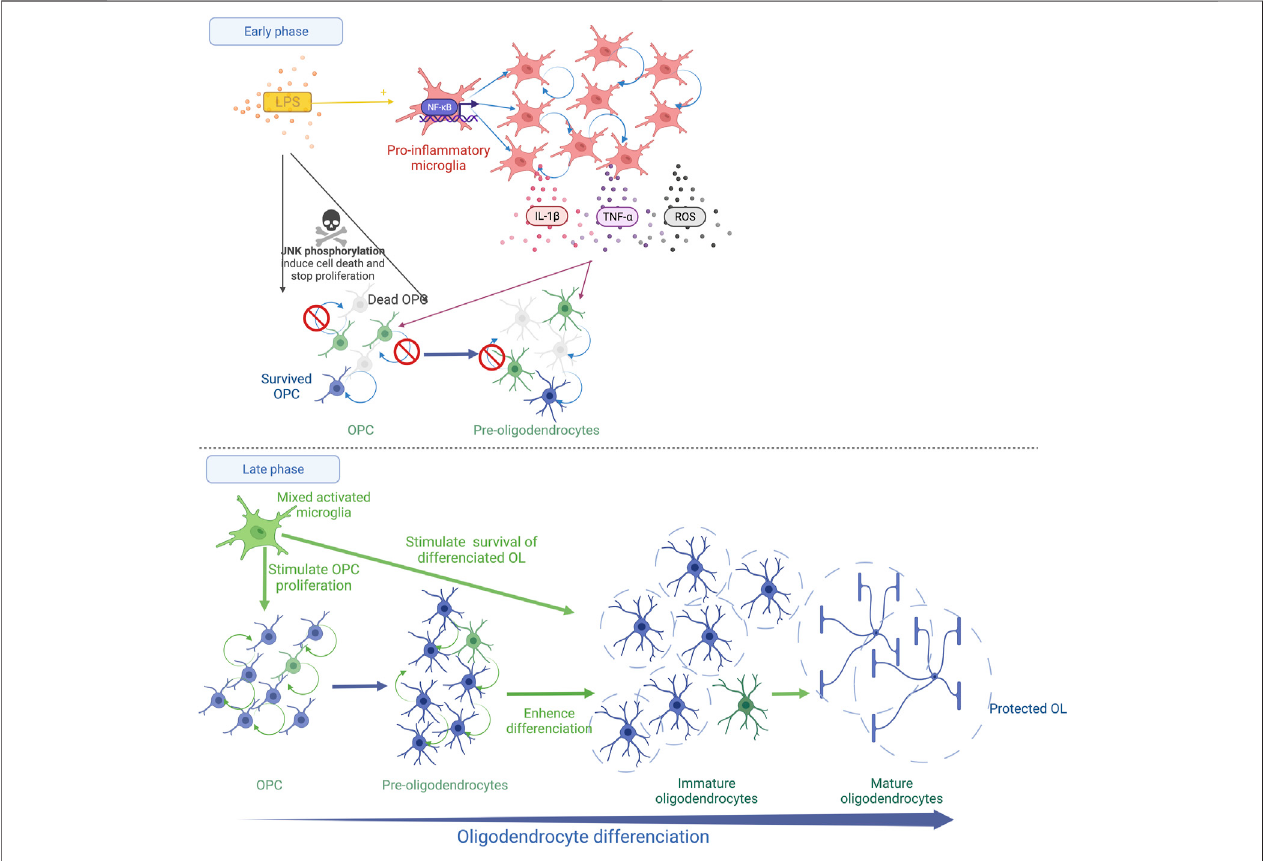
FIGURE 1 | Schematic representation of systemic LPS action on OL lineage in the developing brain. The immediate LPS effect consists in the recruitment and the activation of microglia, which releases pro-in fl ammatory cytokines (TNF- α and IL-1 β ) and reactive oxygen species (ROS). This strong microglial activation leads to OPC/ Pre-OL death and a reduction in OL proliferation (Early phase). Thereafter, a recovery phase occurs and microglia show a trophic phenotype. The proliferation of OPCs/ Pre-OLs, the differentiation of OLs and the survival of mature OLs are promoted (Late phase).